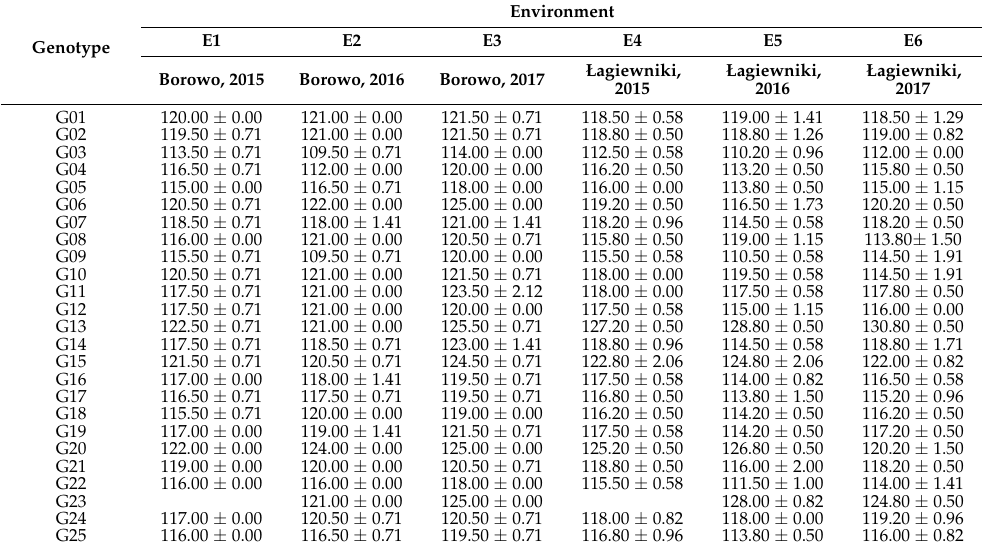
Table 8. Mean values ± standard deviations (s.d.) for the beginning of flowering of winter oilseed rape genotypes in particular environments.